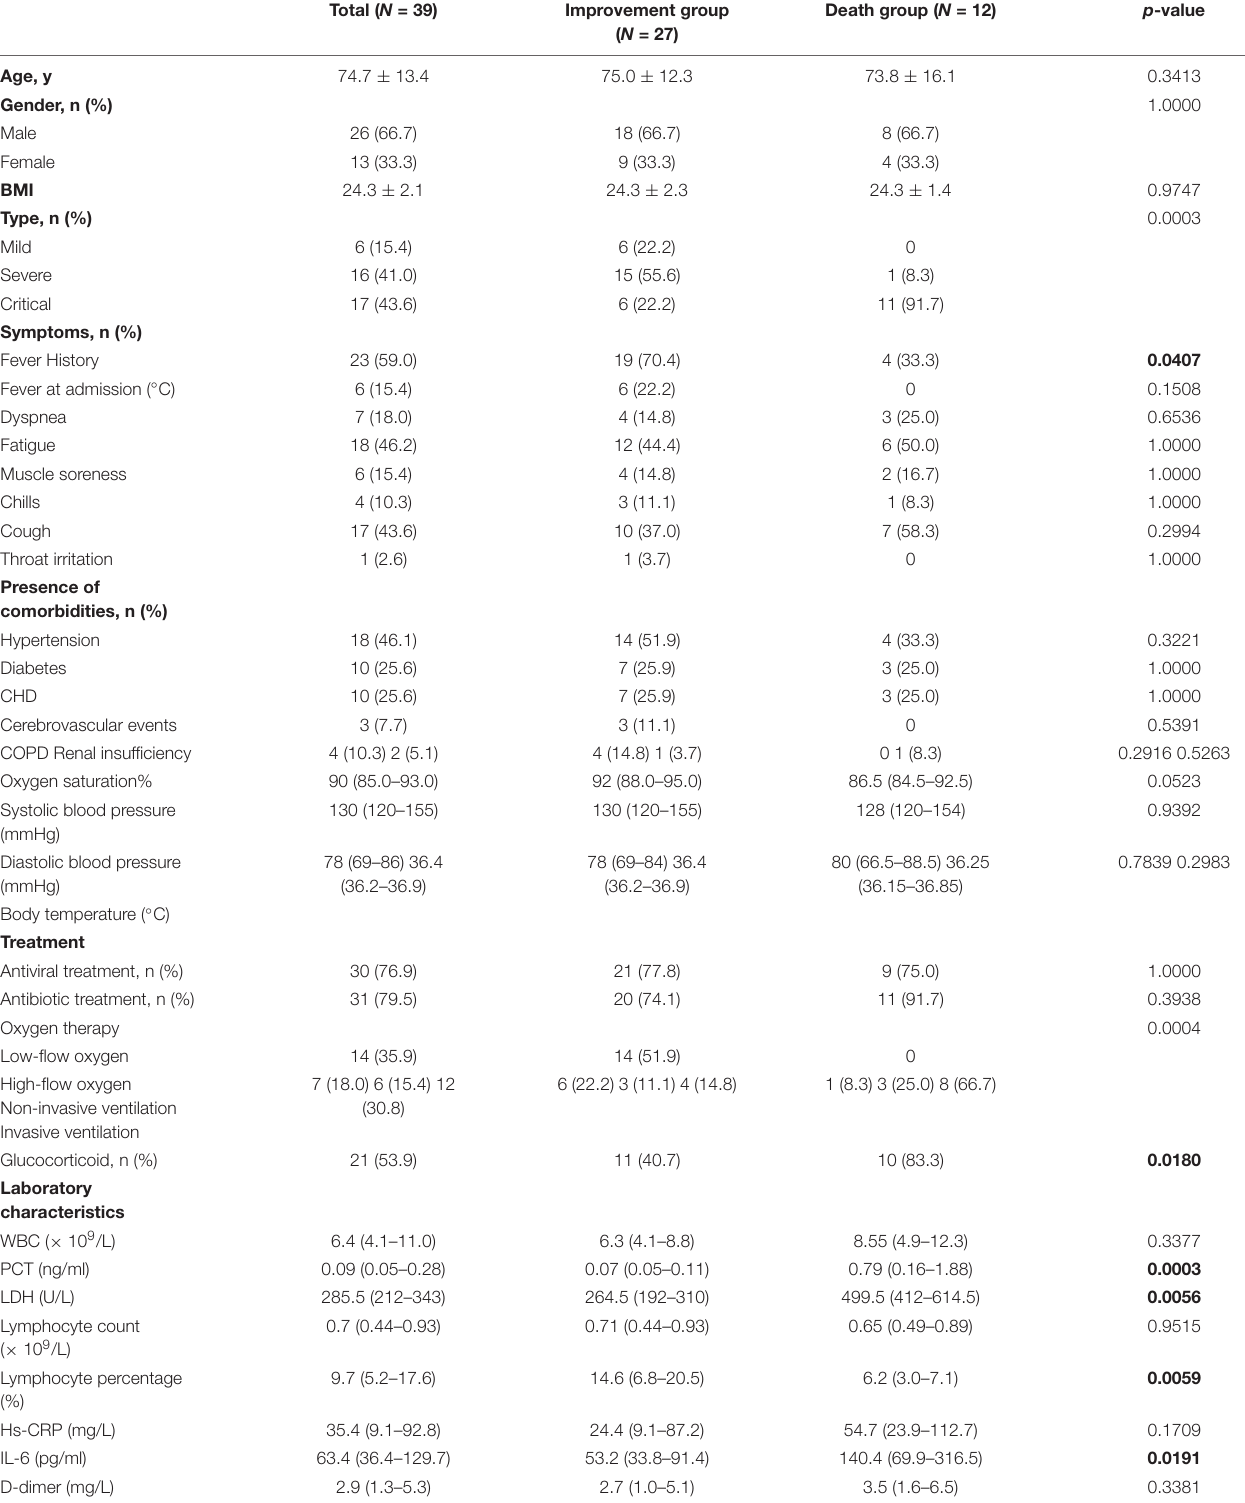
TABLE 2 | Clinical characteristics of the patients with COVID-19 in the improvement group or the death group after receiving TCZ. Total ( N =